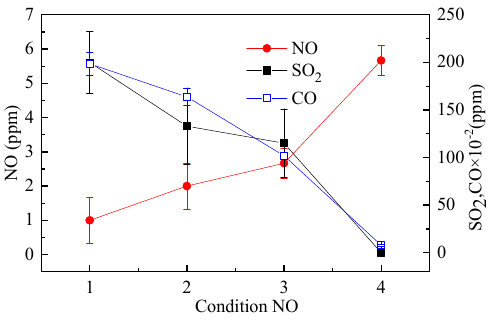
Figure 12. Trends and comparisons of NO and SO 2 and CO under four test conditions.